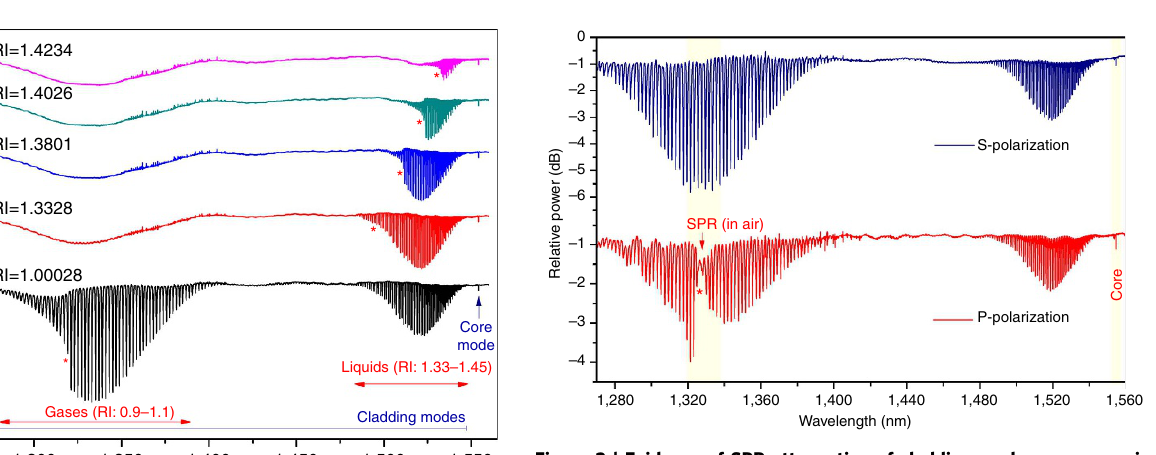
Figure 2 | Evidence of SPR attenuation of cladding mode resonances in the P-polarized transmitted power spectra of a 37 (cid:2) TFBG coated with 50nm of gold (red curve). The resonances in the S-polarized spectrum (blue curve) at the same wavelengths near 1,325nm are not attenuated. Shaded regions of the spectra emphasize the resonances of interest near the SPR (used for refractometric sensing) and near the Bragg resonance at 1,555nm (for temperature compensation).